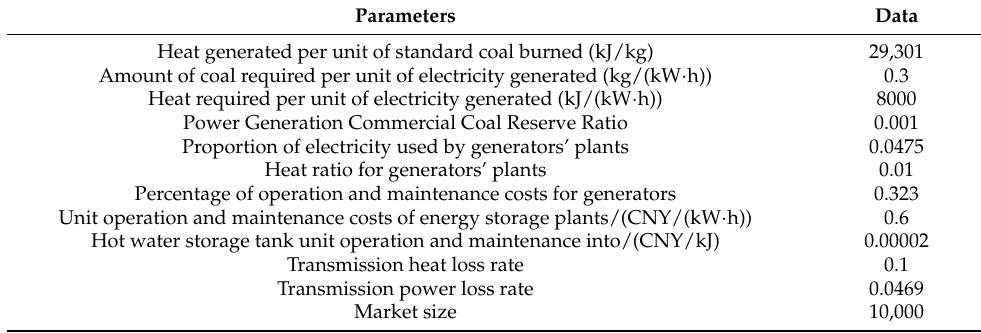
Table 4. Parameters related to coal-fired